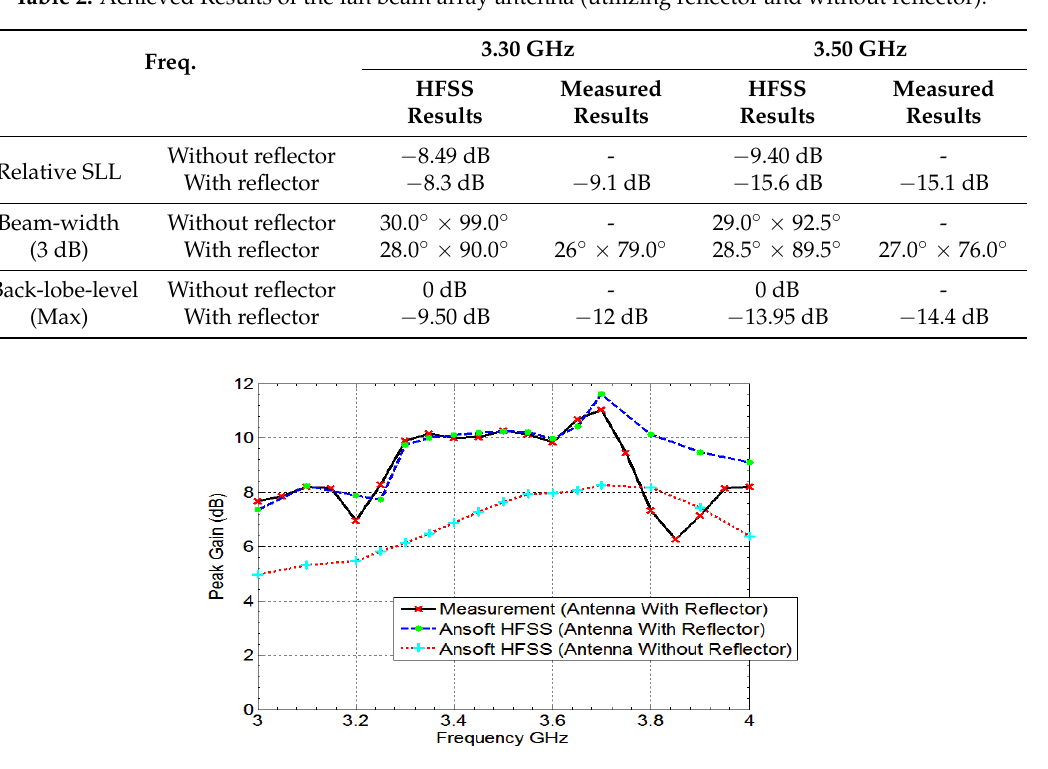
Figure 8. Measured and Simulated Gain (dB) of the developed antenna array having fan beam with and without a reflector.